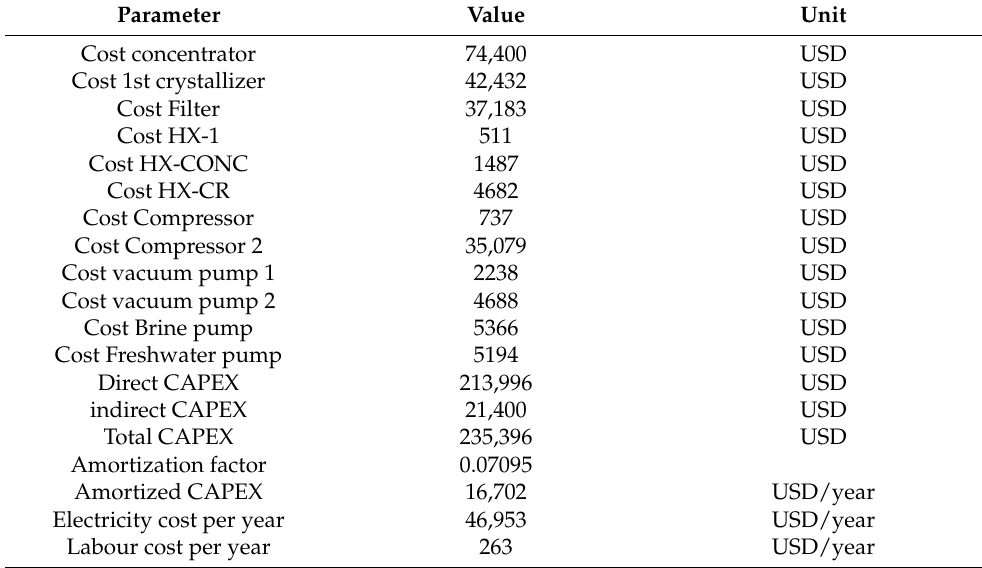
Table 15. Economic results for the conventional ZLD system for 1000 kg/h of feed